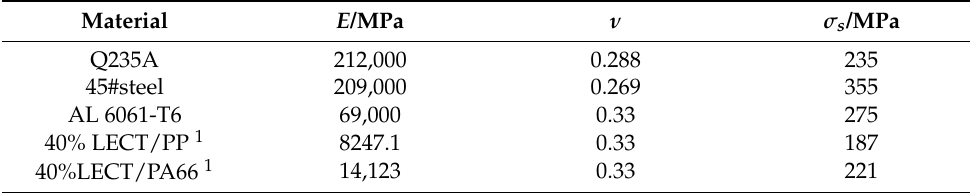
Figure 5. Mesh convergence test of different mesh sizes. Table 2. Mechanical properties of competing